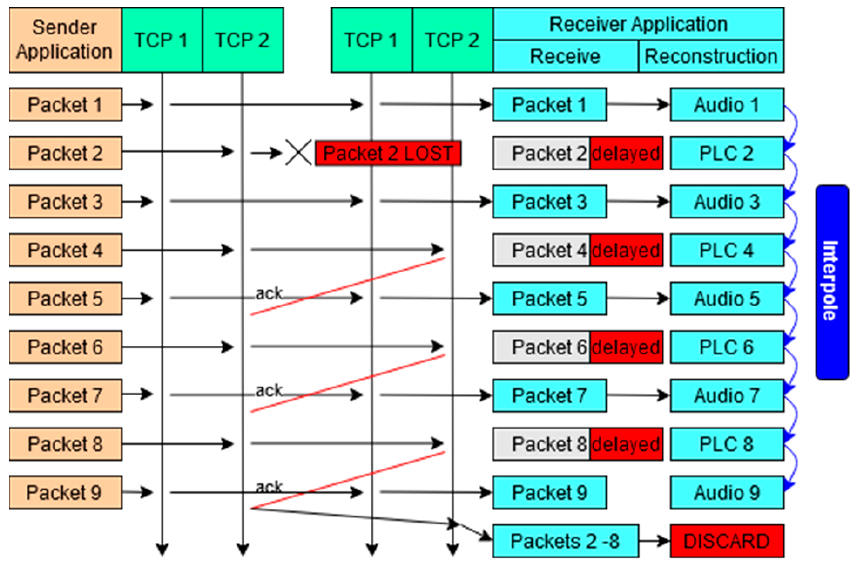
Figure 3. Diagram showing the application of multiple TCP streams to reduce packet loss and delay.